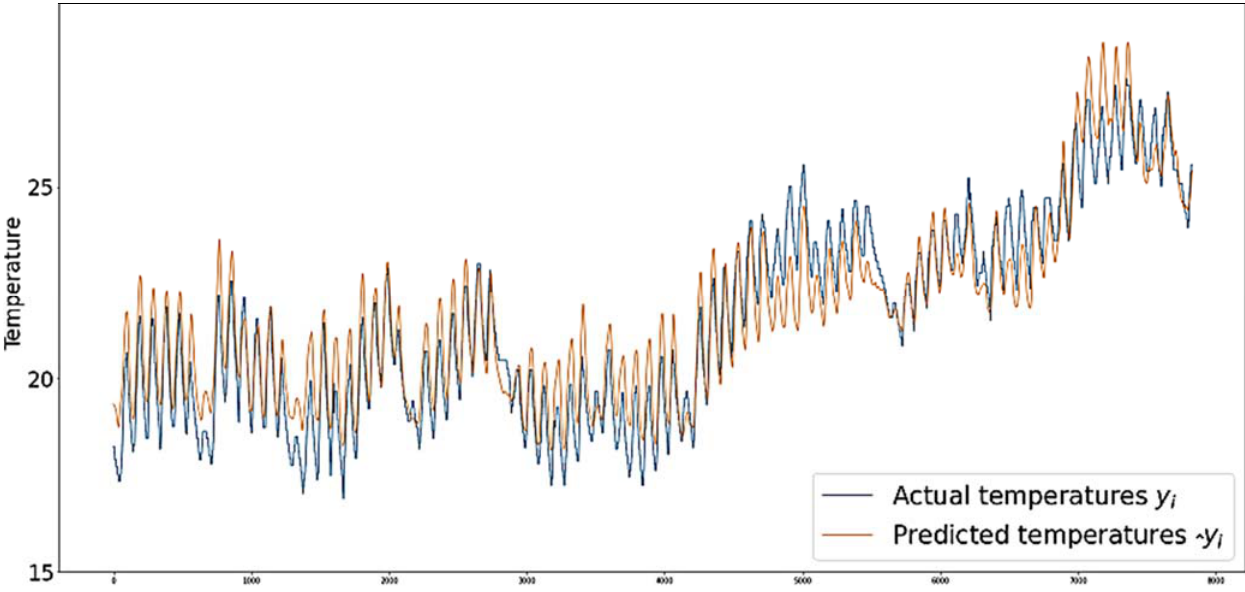
Figure 20. Plot of actual and predicted temperatures 5 h ahead for office 40 on the third floor.